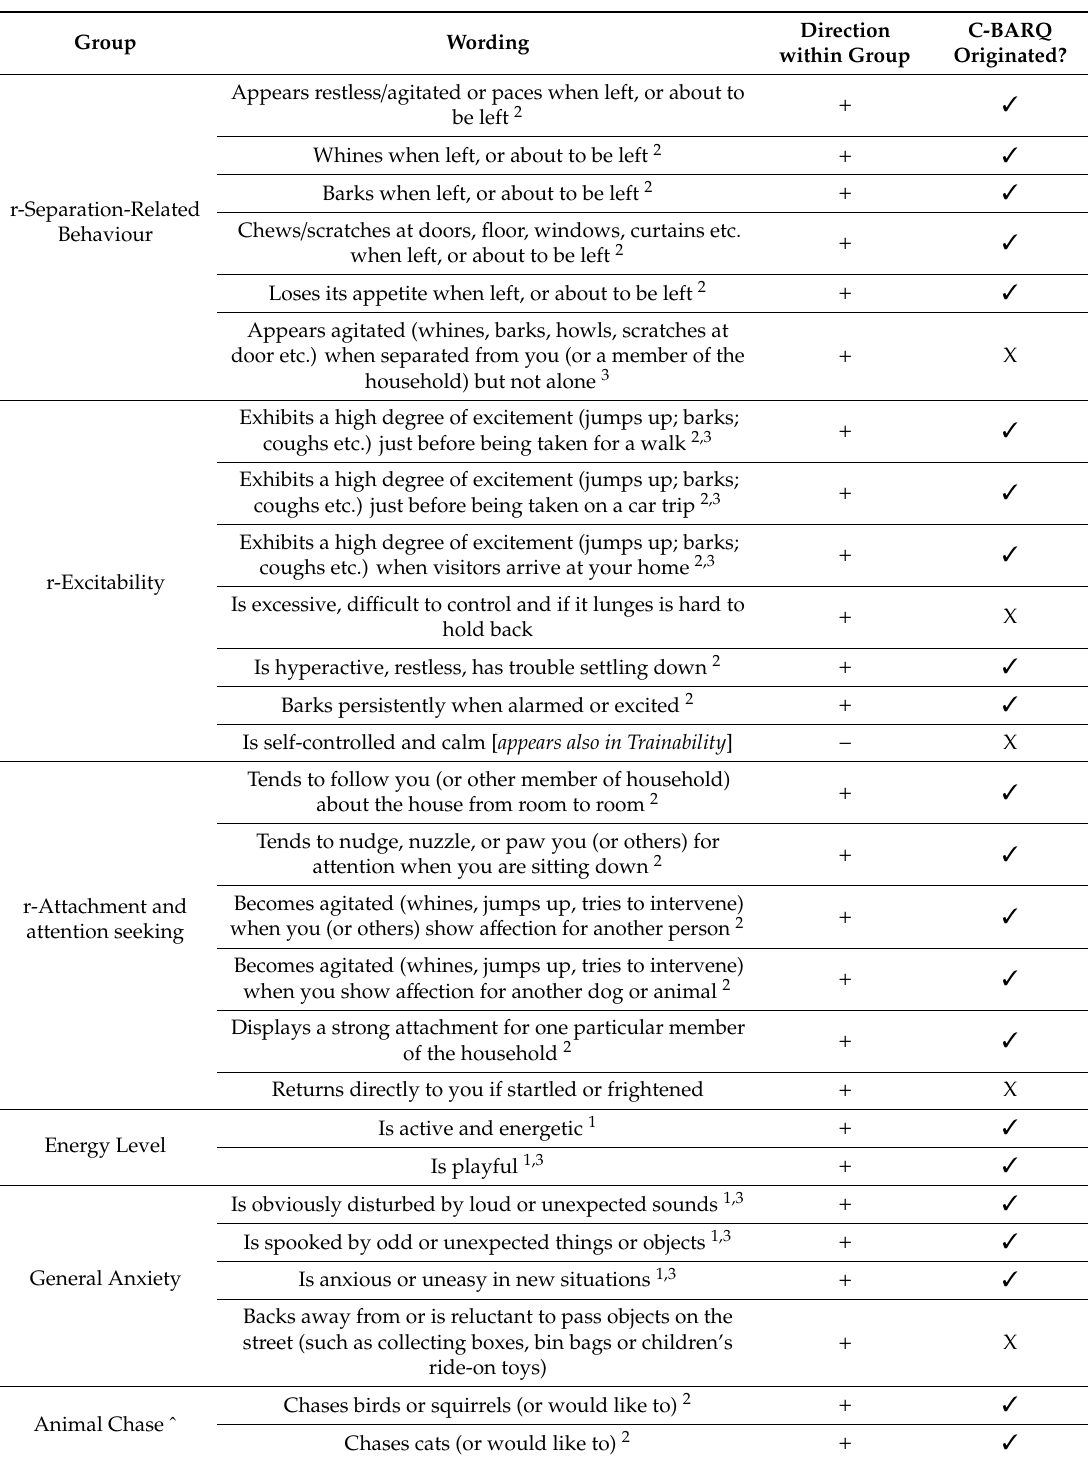
Table 1. Question group and wording for r-PWQ questionnaire, including the direction of association between the individual item within the group (negatively valanced items were transformed before average trait scores were calculated) and whether questions originated from the C-BARQ. Superscripts are used to indicate the origin of individual